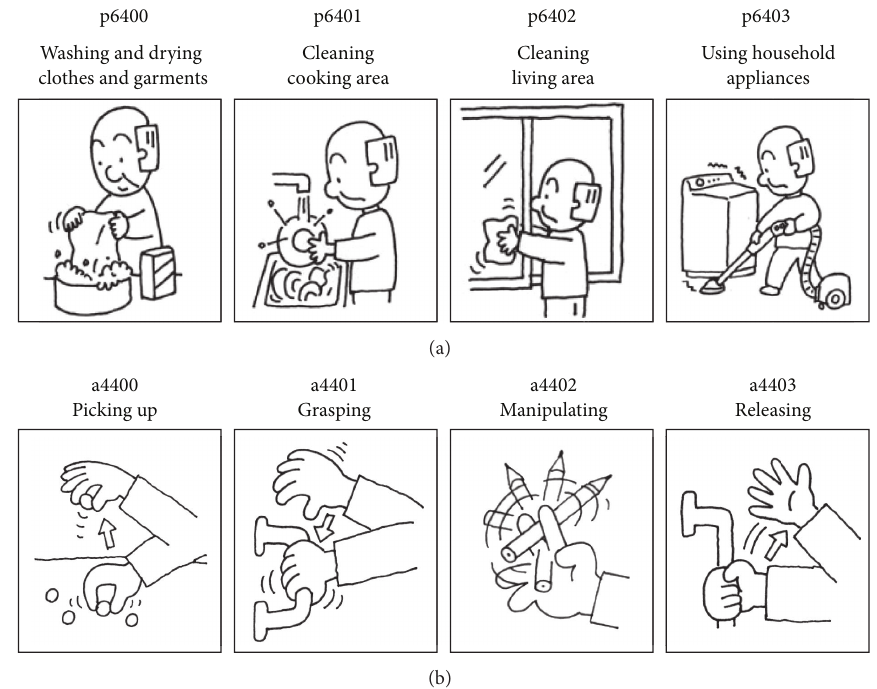
Figure 1: Examples of participation-level (a) and task-level (b) activities and corresponding codes [10].